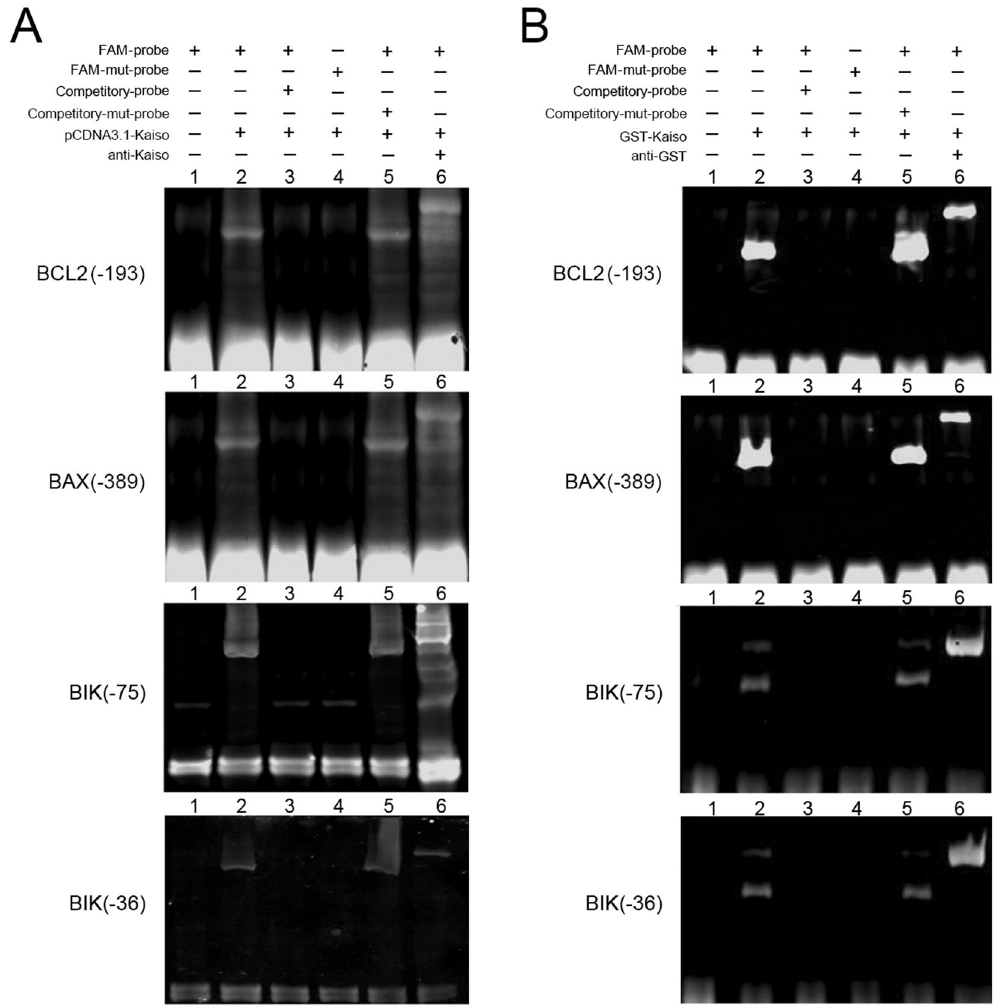
Figure 8. Kaiso binds to specific KBSs on BCL2, BAX and BIK promoter. Nonradioactive EMSA was performed using probes targeted to the promoter positions that contain putative KBSs (BCL2: − 193 bp, BAX: − 389 bp, BIK: − 75 bp, − 36 bp). Wild type probes were labeled with 6-FAM and were incubated with cell nuclear extracts from HUVECs overexpressing Kaiso ( A , lane 2–5) or with recombinant protein GST-Kaiso ( B , lane 2–5). Labeled wild type probes (FAM-probe) alone served as a negative control (lane 1). Monoclonal mouse anti-Kaiso 6F/ 6F8-CHIP grade antibody ( A , lane 6) and monoclonal mouse anti-GST antibody ( B , lane 6) were used to detect super gel shift. Unlabeled wild type probes (Competitory-probe) served as competition. KBS-mutated probes (FAM-mut-probe and Competitory-mut-probe) served as a negative control and